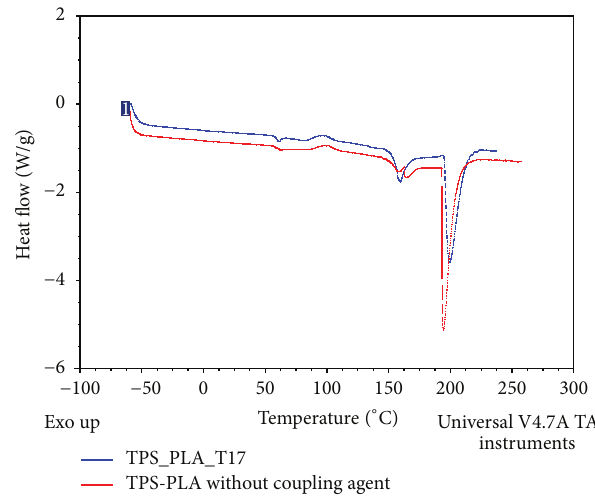
Figure 4: DSC of samples of TPS/PLA